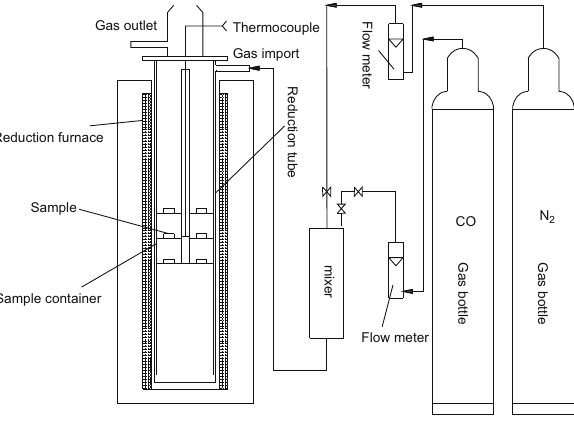
Figure 1: Testing device for RSI and reducibility degree